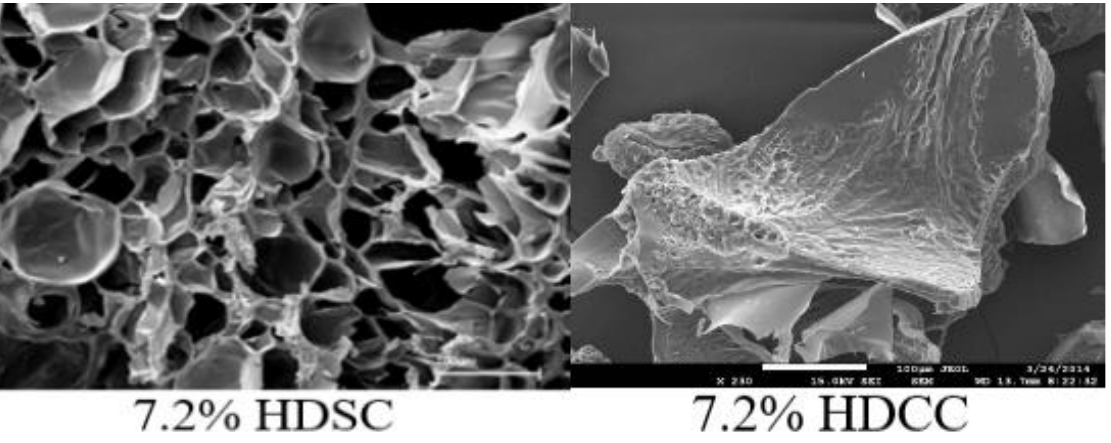
Figure 2. SEM micrographs of 7.2% HDSC ( left ) and 7.2% HDCC ( right ) in magnification 1400×.